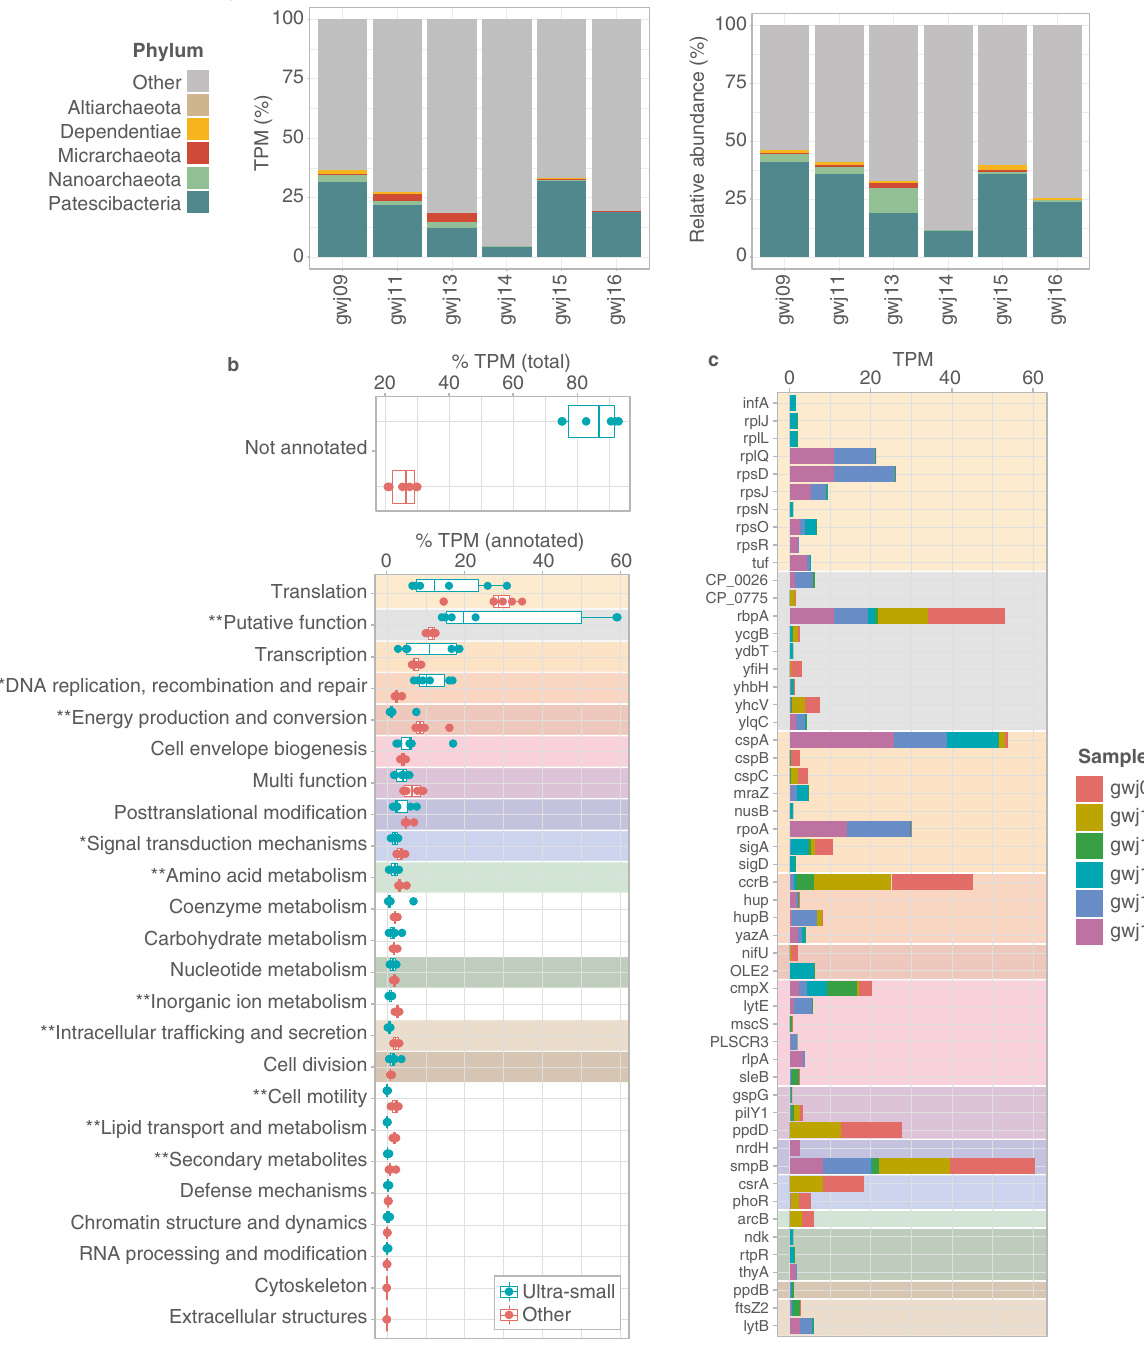
Fig. 7 Gene expression pro fi les of ultra-small microorganisms. a Proportion of total modi fi ed-TPM expressed by ultra-small prokaryotes (left). Modi fi ed-TPM was normalized based on the genome size of respective MAGs. Genome relative abundance of ultra-small prokaryote MAGs compared to the rest of the communities (right). Taxonomy is indicated at phylum level. Groundwater for samples gwj09,11 was oxic with 0 – 0.8 g/m 3 DOC, and for gwj13 – 16 was dysoxic with 3.1 – 26 g/m 3 DOC. b Proportion of expressed genes not assigned ( “ Not annotated ” , upper plot) or assigned (lower plot) to COG functional categories in ultra-small prokaryotes and other groundwater microorganisms. The center line of each boxplot represents the median; the top and bottom lines are the fi rst and third quartiles, respectively; and the whiskers show 1.5 times the interquartile range. Signi fi cant differences were assessed for each function using Wilcoxon Signed Rank (** p < 0.01, * p < 0.05). Meaning of box-plot elements described above. c Expression of the top 20 genes annotated with a gene name across samples. Expression of cspA,B,C genes (cold shock proteins) is likely due to the sample preservation method used. Plot background colors denote the same functional categories in ( b ) and ( c ). The grey background shading indicates genes in the EggNOG ‘ Function unknown ’ category, which are assigned a putative function based on sequence orthology with poorly characterized